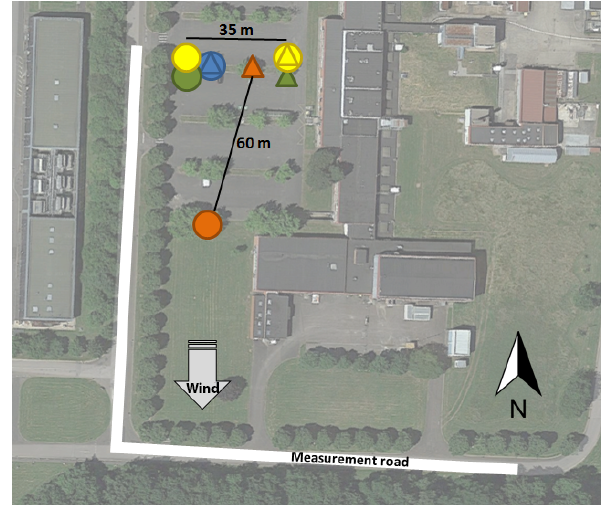
Figure 2. The four tracer release configurations tested. Triangles represent the tracer source locations, and the circles mark methane sources. Each colour represents a configuration: blue is configura- tion 1 (collocated tracer), red is configuration 2 (upwind tracer), green is configuration 3 (lateral tracer) and, yellow is configura- tion 4 (multiple